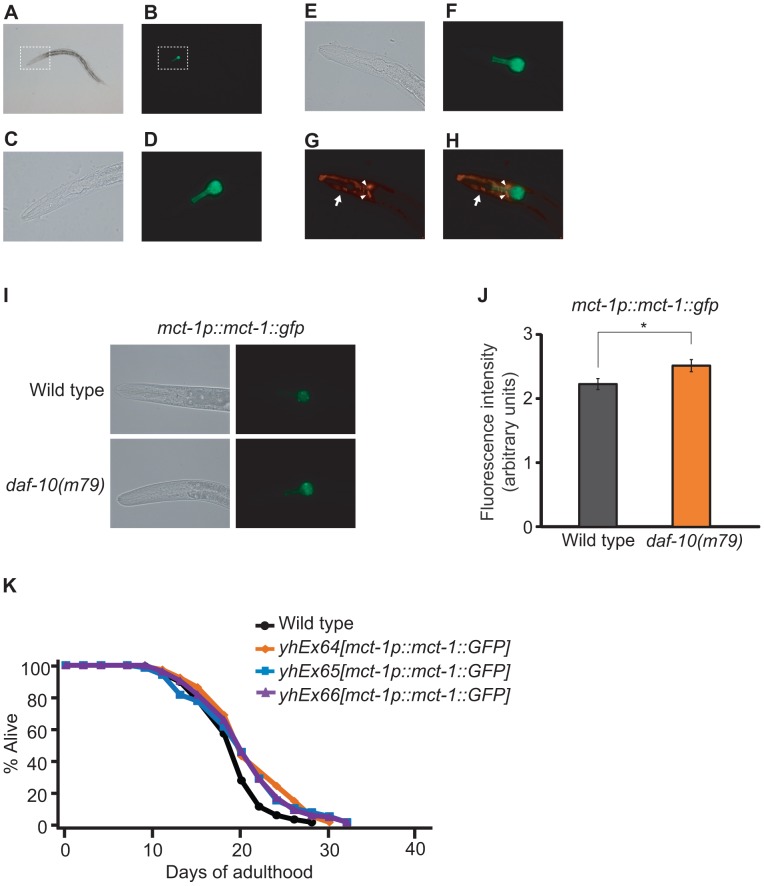
Overexpression of mct-1 extends lifespan.A–D. Expression pattern of GFP-fused MCT-1 protein in mct-1p::mct-1::GFP transgenic animals. Bright field image (A) and green fluorescence image (B) of an L4 mct-1p::mct-1::GFP transgenic larva. Magnified bright field image (C) and green fluorescence image (D) of dotted box regions in A and B respectively. E–H. The expression of GFP-fused MCT-1 protein in the mct-1p::mct-1::GFP transgenic animal did not overlap with the signal from amphid sensory neurons labeled with the DiI dye. Bright field image (E), green fluorescence image (F), red fluorescence image (G) and overlay of green and red fluorescence images (H) of the head of an L3 mct-1p::mct-1::GFP transgenic animal. Arrowheads indicate cell bodies of amphid sensory neurons that are stained with DiI dye. The arrow indicates body wall muscle that expresses a muscle-specific myo-3p::RFP transgene, used as a marker for the generation of the transgenic animals. I–J. Expression pattern of GFP-fused MCT-1 protein in daf-10(m79) mutants, including representative green fluorescence and bright field images (I) and quantification of fluorescence intensity (J). Error bars represent s.e.m. (* p<0.05, Student's t-test). K. Overexpression of mct-1::GFP lengthens lifespan. Three independent lines of mct-1 transgenic animals lived slightly but significantly longer than control animals. Statistical analysis of the lifespan data presented in this figure and additional repeats is included in Table S1B.